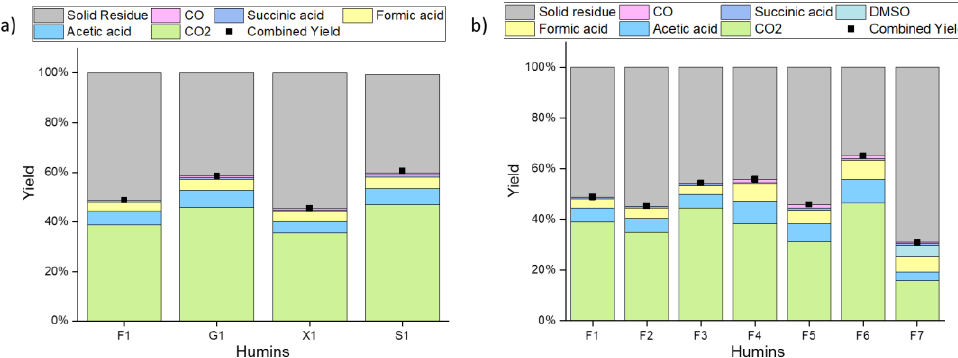
Figure 8. Oxidative conversion of humins using HPA-5 as a catalyst; reaction conditions: m (humin) = 75 mg, m(HPA-5) = 7.5 mg, T = 90 °C, t = 15 h, p = 30 bar O 2 in 7.5 mL water as a solvent. ( a ) humins derived from different sugars ( b ) humins synthesized using different acids and solvents (determined via Equation (S3)). Table 4. Product yields using different sugar-derived humins; reaction conditions: m (humin) = 75